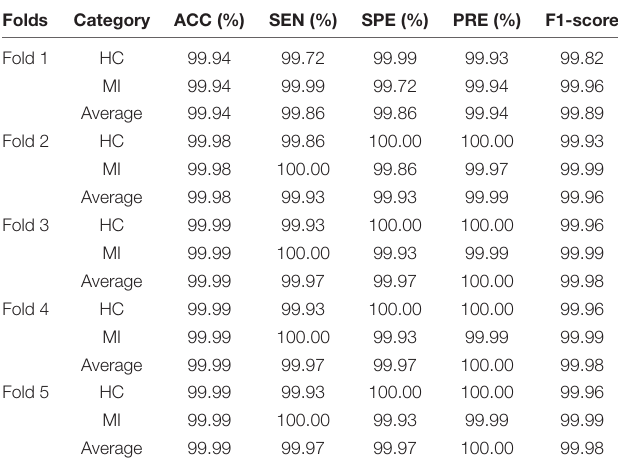
TABLE 2 | Results of five-fold cross validation for MI detection (HC denotes healthy controls).